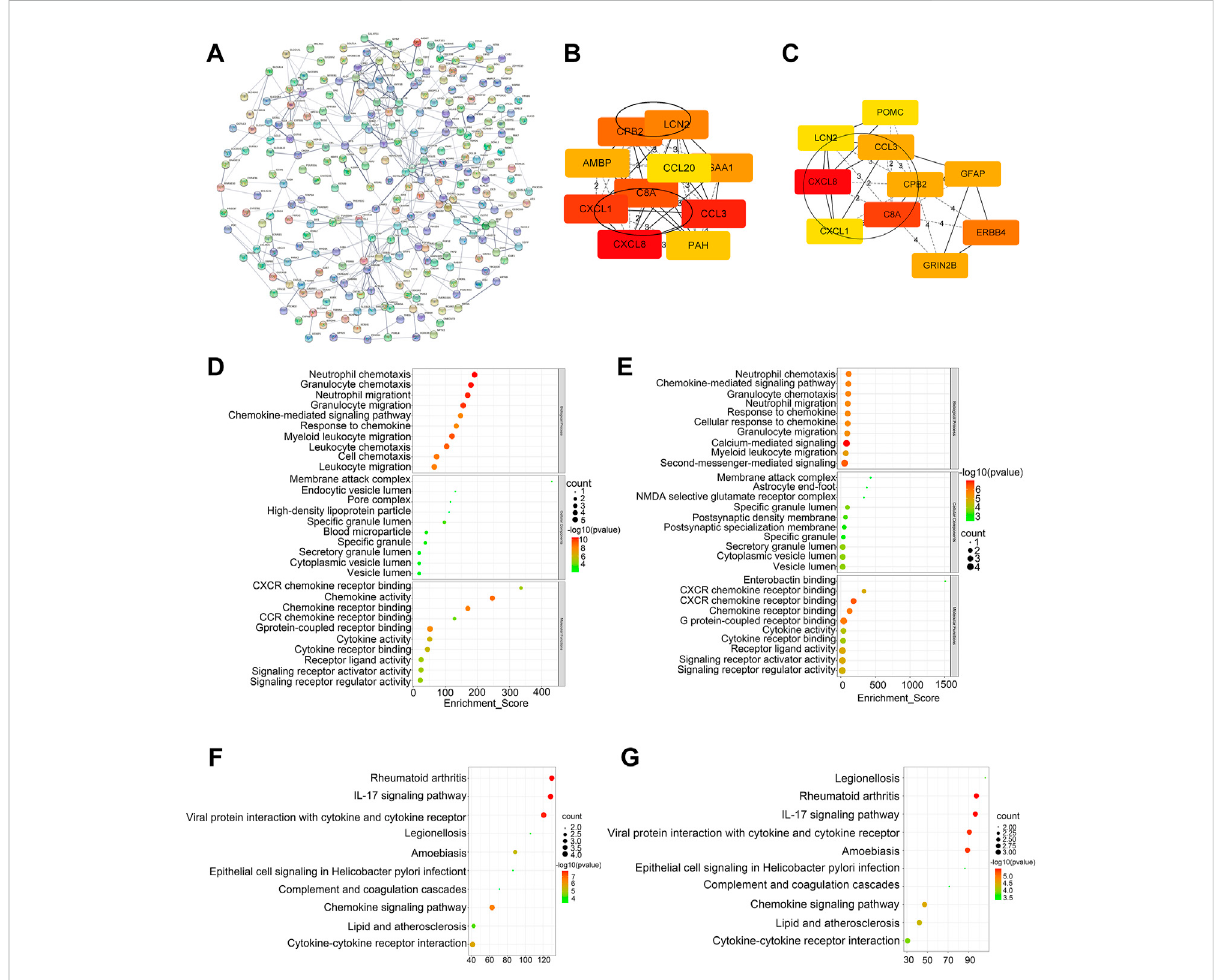
FIGURE 3 Construction of PPI network and screening of hub genes. (A) PPI network of DEGs. (B) Top 10 genes ranked by the MCC method. (C) Top 10 genes ranked by the MNC method. (D – E) GO analysis of top 10 genes ranked by the MCC and MNC method. (F,G) KEGG analysis of top 10 genes ranked by the MCC and MNC